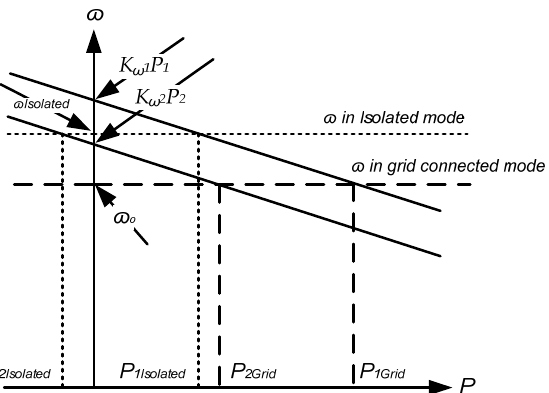
Figure 2. Illustration of droop control in grid connected and isolated mode.